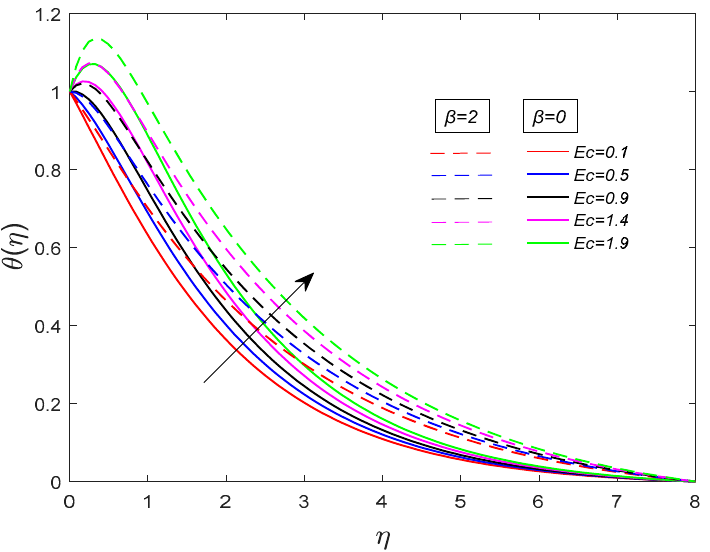
Figure 10. Influence of the Eckert number (Ec) on thermal profile with Pr = 0.7, M = Kr = Sc = 0.5, Sr = 1.5.